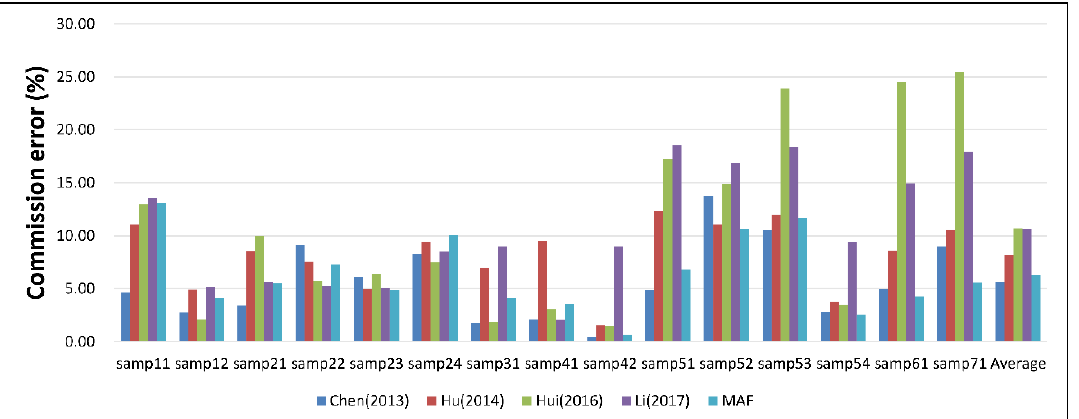
Figure 4. Comparison of omission errors for filtering ISPRS samples.